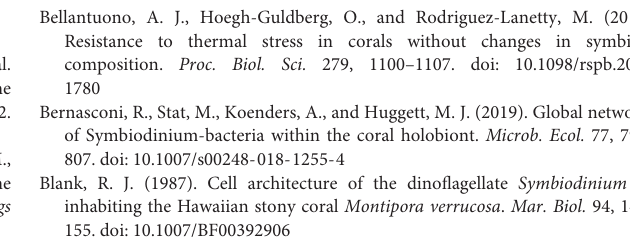
Supplementary Table 1 | Differential abundances calculated with DESeq2. Supplementary Table 2 | Differential abundances calculated with